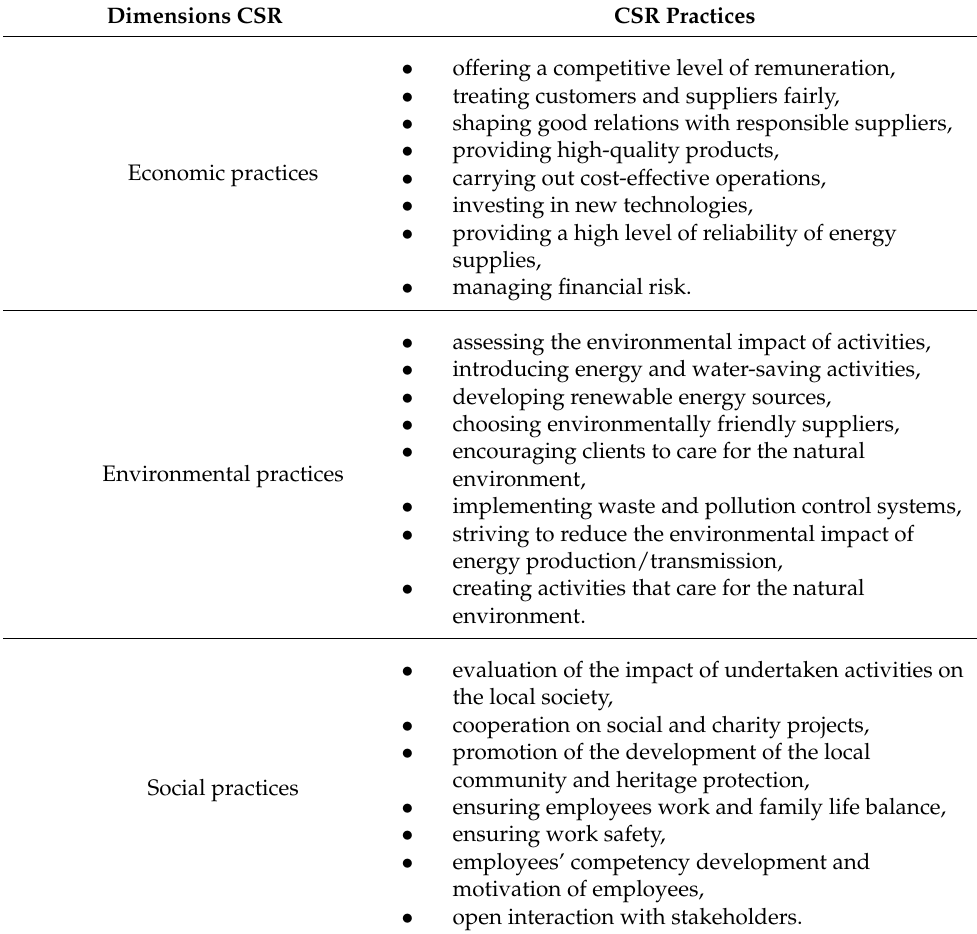
Table 1. Dimensions and CSR